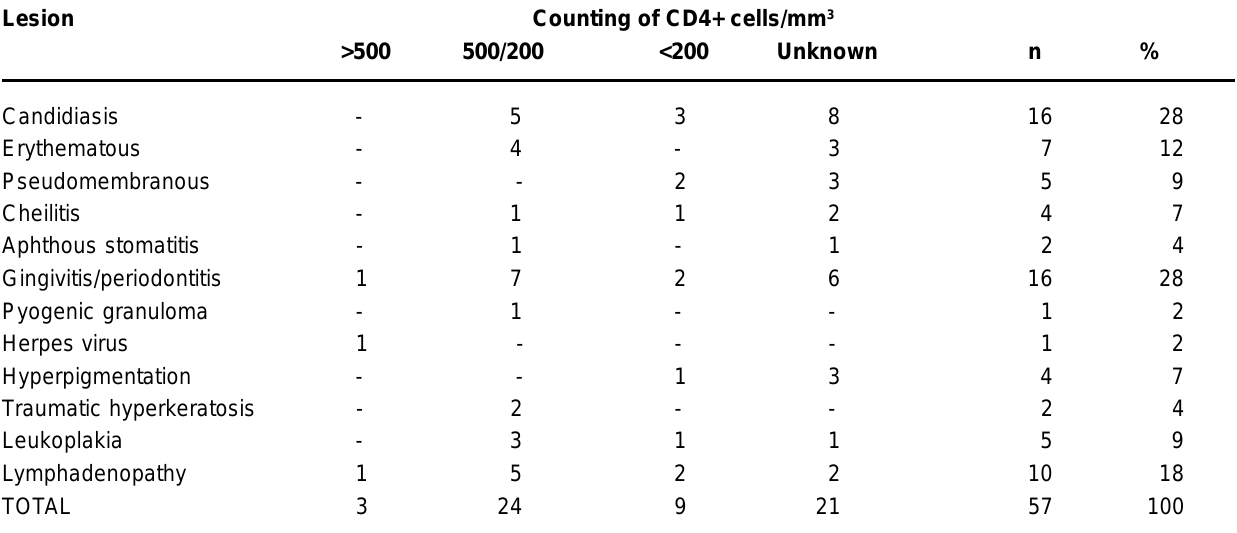
TABLE 3- Oral lesion x CD4+ cells/mm 3 of